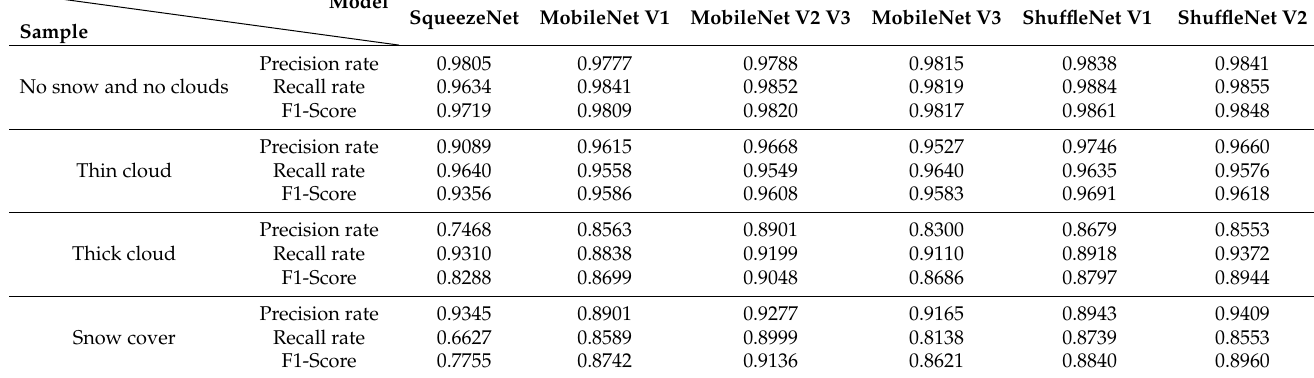
Table 6. Classification and evaluation index analysis of cloud and snow recognition network